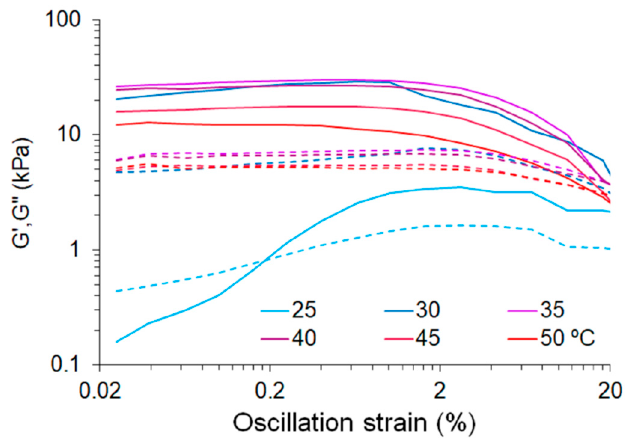
Figure A4. Oscillatory rheology of APsIPN80 solutions. Storage (G’, solid line) and loss (G”, dashed line) components of shear modulus versus oscillation strain for APsIPN80 12 wt % solutions in CHCl 3 :MetOH 3:1 at different temperatures.